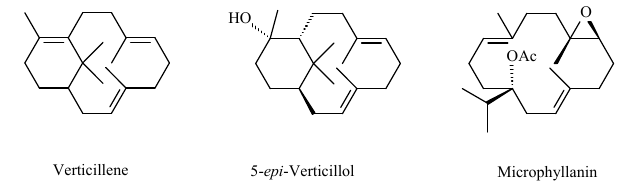
Figure 3. Diterpene compounds isolated from B. microphylla [31].